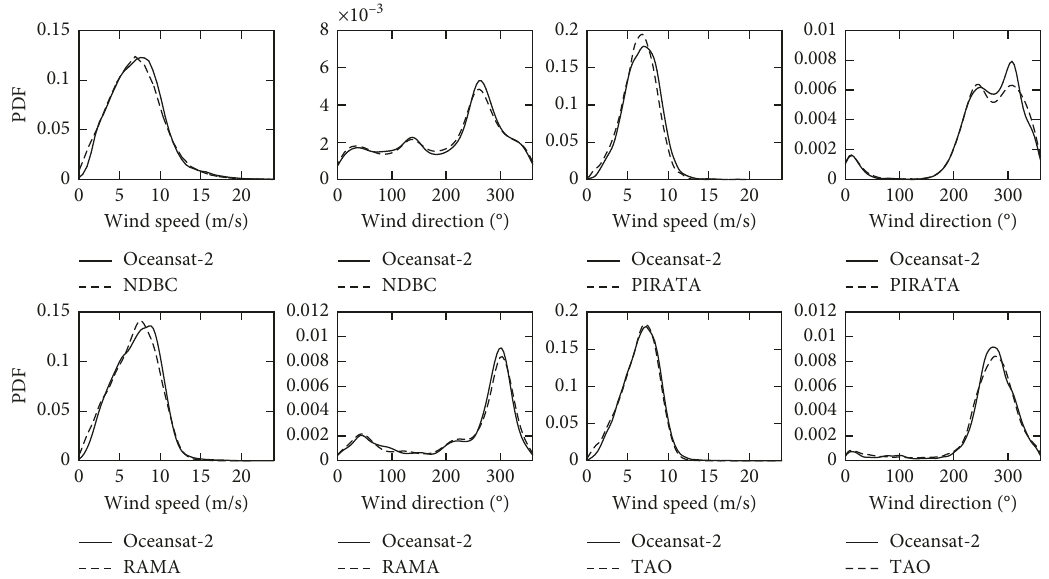
Figure 5: PDFs of the collocated OSCAT and moored buoy wind speeds and directions in the bin of 1 m/s and 10 ° .